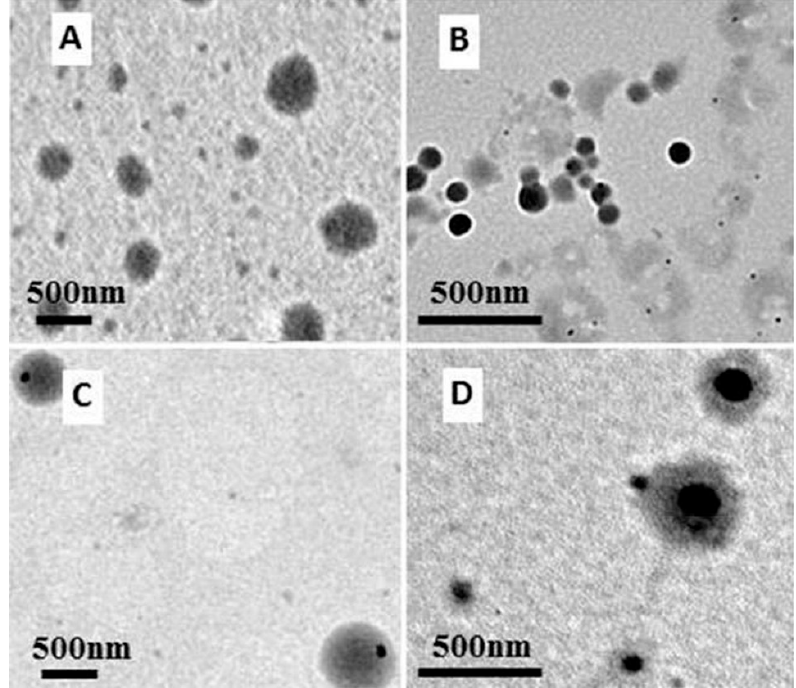
Figure 1. TEM pictures of gold-polystyrene hybrid nanoparticle (molar ratio of Au NPs and disulfide initiator: ( A ) 1/100; ( B ) 1/1000; ( C ) 1/10,000; ( D ) 1/20,000. Reproduced with permission from reference [64].